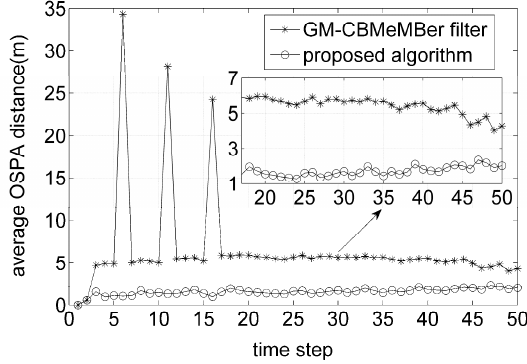
Figure 5. Average optimal subpattern assignment (OSPA) distances for different algorithms.